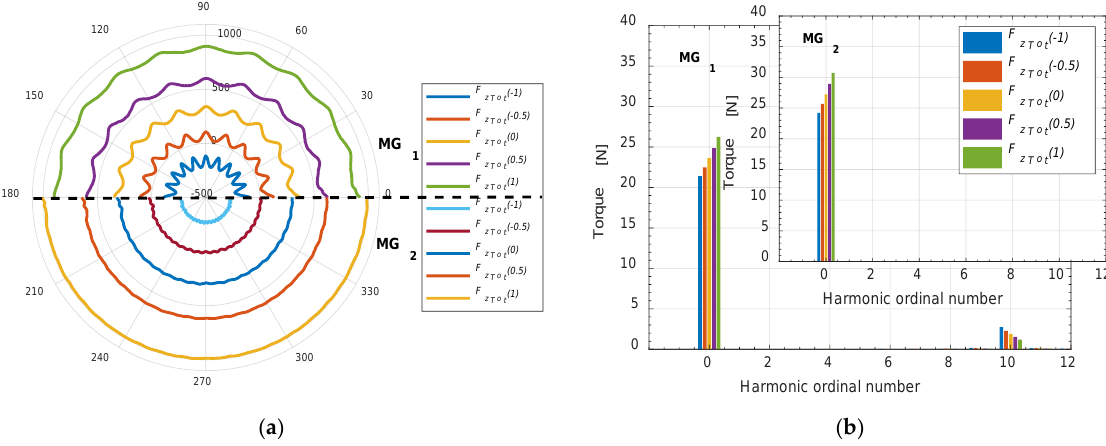
Figure 11. Global force components acting on whole modulator vs. inner rotor angle and air gap asymmetry ( Ag asm ), for the two gear variants (MG 1 and MG 2 ) at ( a ) max load; ( b ) FFT spectra of magnetic torque.